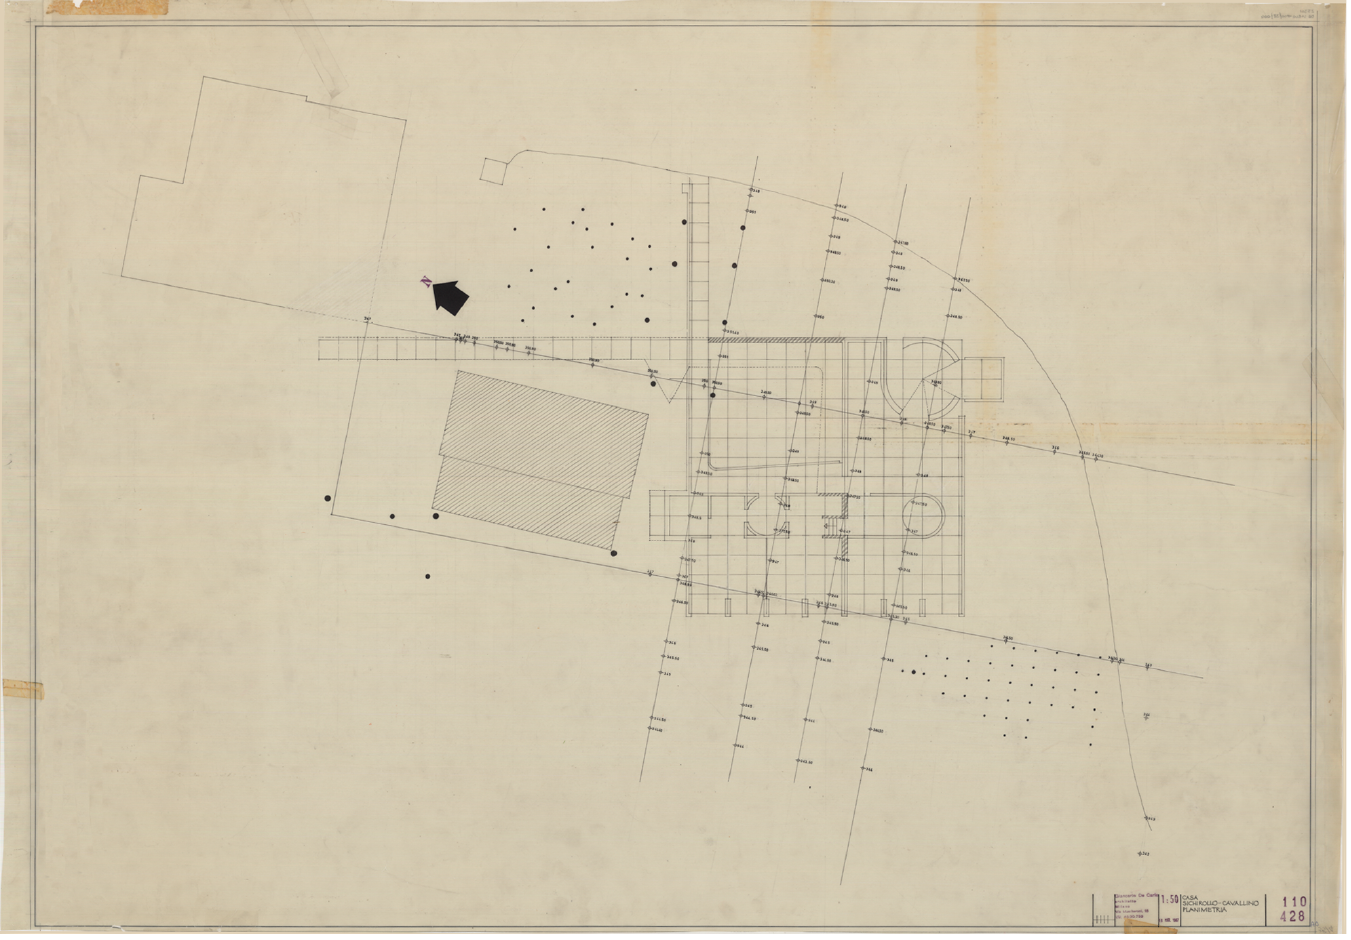
Ca’ Romanino. Ode to the landscape. Ca’ Romanino is developed on a pre-existing rural house, located to the left of the matrix that configures Ca’